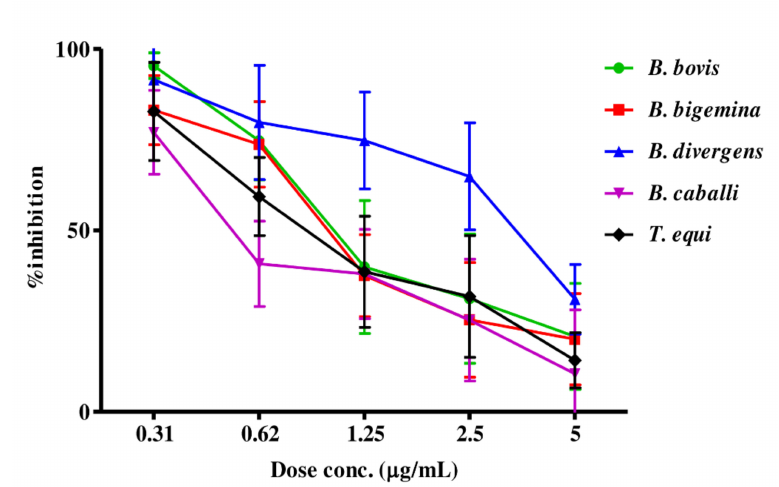
Figure 1. Dose-response curves of MEBV against Babesia and Theileria parasites in vitro. The curves showing the correlation between the percentage of inhibition and the concentration of MEBV ( µ g / mL) on B. bovis , B. bigemina , B. divergens, B. caballi and T. equi . The values obtained from three separate trials were used to determine the IC 50 ’s using the non-linear regression (curve fit analysis) in GraphPad Prism software (GraphPad Software Inc., La Jolla, CA, USA).